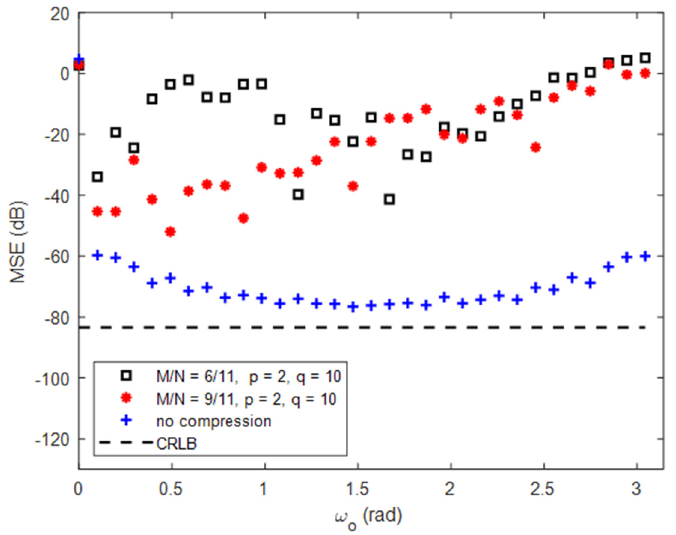
Figure 6. Frequency estimation mean square error versus ω o for the white noise case. SNR = 30 dB, α = 5 and B = 10, using CCS with different compression ratios as well as the estimator without compression [27], p = 2, q = 10.